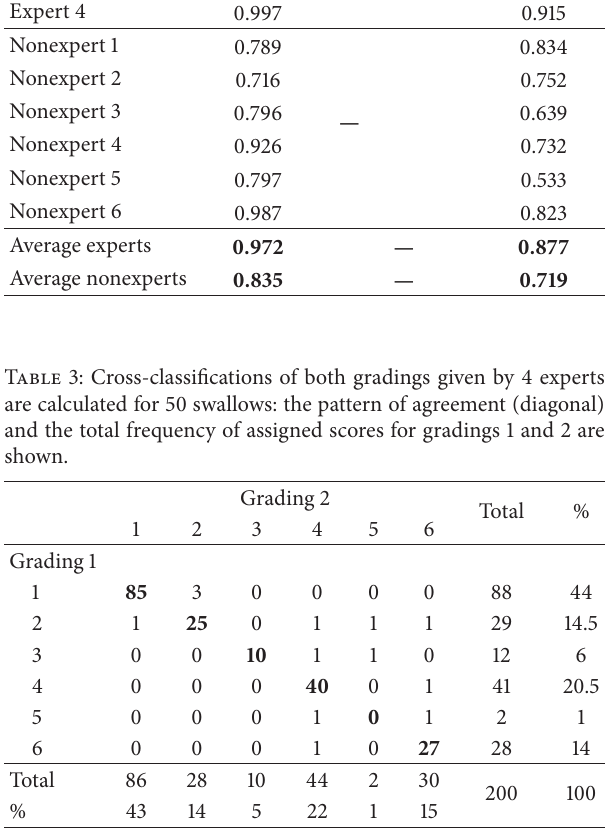
Table 2. The intrarater reproducibility of the BRS was almost